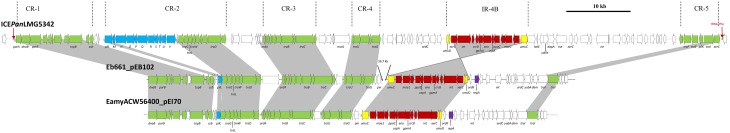
Schematic diagram of ICEPanLMG5342 and the phylogenetically related conjugative plasmids pEI70 of E. amylovora ACW56400 and pEb102 of E. billingiae Eb661. ICEPanLMG5342 is aligned with the plasmids pEI70 of E. amylovora ATCC56400 (NC_018999.1) and pEb102 of E. billingiae Eb661 (NC_014304.1). Dark gray shaded regions and green arrows indicate the conserved CRs between the ICEs. The conserved umuCD island is marked by red arrows, with the umuC fragments and umuD genes colored in yellow, and the plasmid replication gene repA in pEI70 and pEb102 is colored purple.